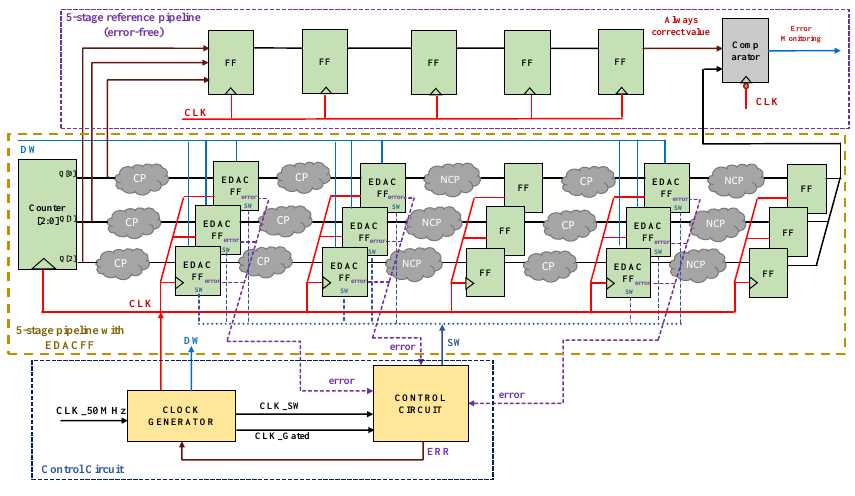
Figure 6. Block diagram of testing EDACFF